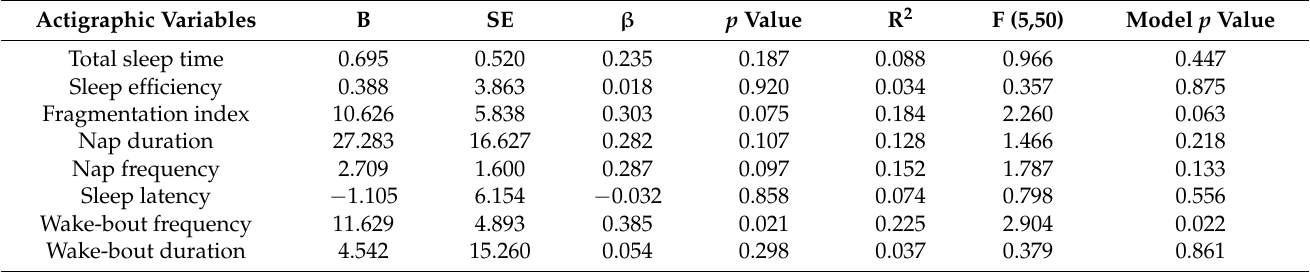
Table 5. The association of androgen deprivation treatment and actigraphic sleep measurements, after adjusting for age, ethnicity, WHO performance score and T cancer